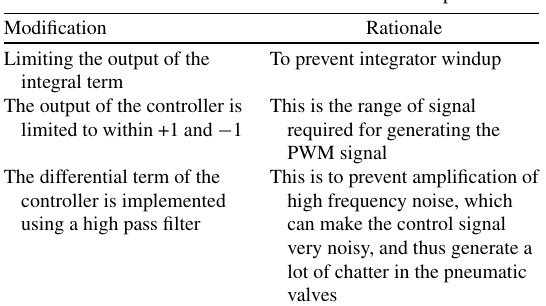
Fig. 4. Illustration of the idea of reachable workspace used in the adaptive active-assist therapy mode. Table 1 Modifications to the PID structure used in the inner-loop